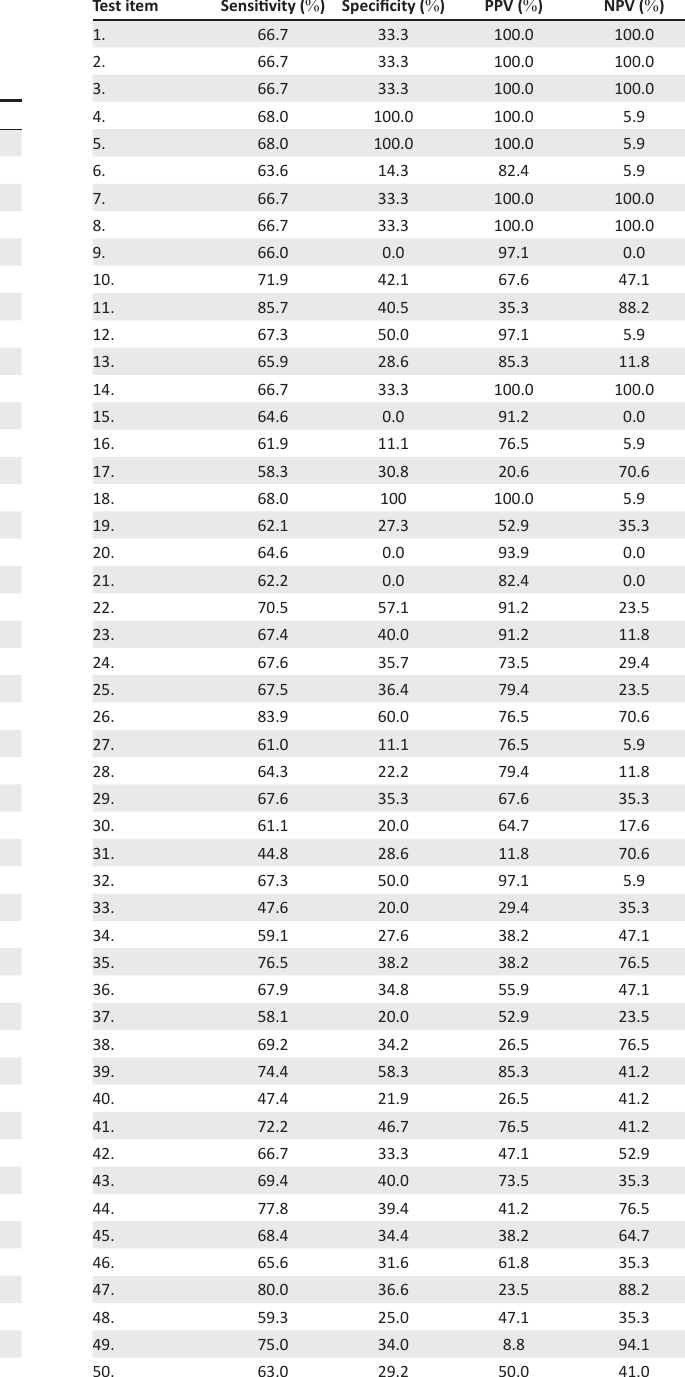
TABLE 2-A1: Test item-specific validity measurements.